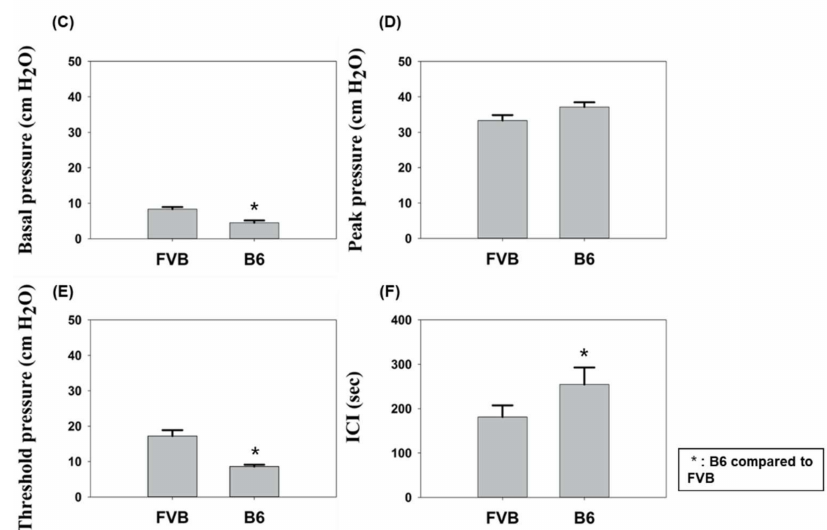
Figure 2. Cystometrogram (CMG) data line charts of ( A ) FVB and ( B ) B6 mice from control groups. Bladder pressure is shown above the bold black line, and output volume below. CMG test results of both strains are shown for ( C ) basal pressure, ( D ) peak pressure, ( E ) threshold pressure, and ( F ) intercontraction interval